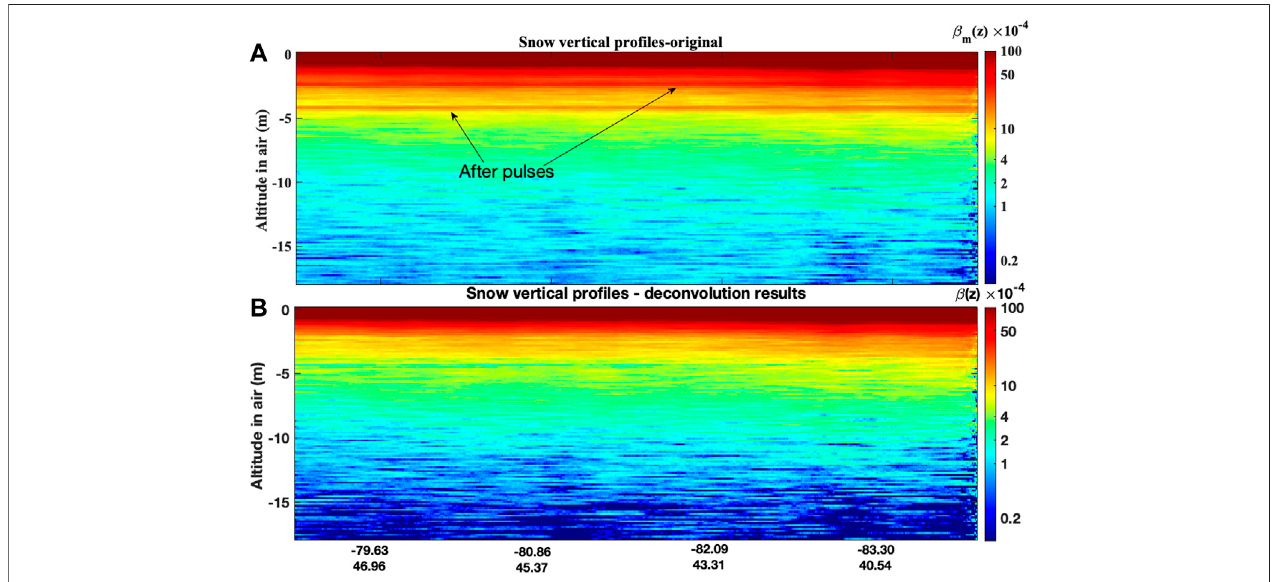
FIGURE2 | Snow pro fi les derived from ICESat-2 measurementsalong ground track over Antarctica before (A) and after (B) deconvolution. The after-pulse effects arecorrectlyremovedbydeconvolutionprocess.Thecolorsrepresentthephotoncountsnormalizedbythesnowsurfacephotons.Thesnowsurfaceissettobeat0 m. Altitudes below the snow surface are represented as negative values.